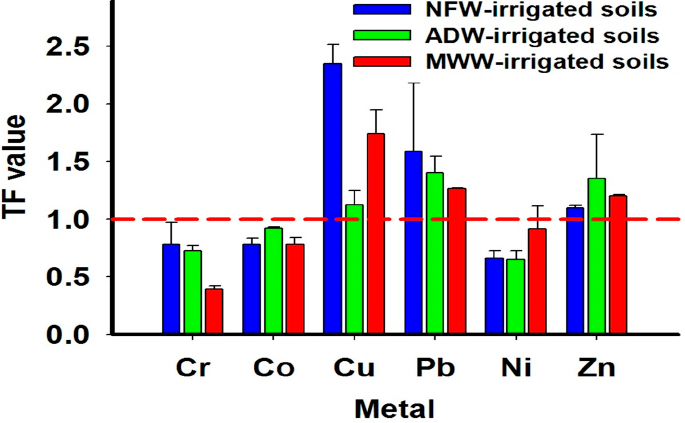
Figure 6. Metal translocation factor (TF) of berseem shoots.